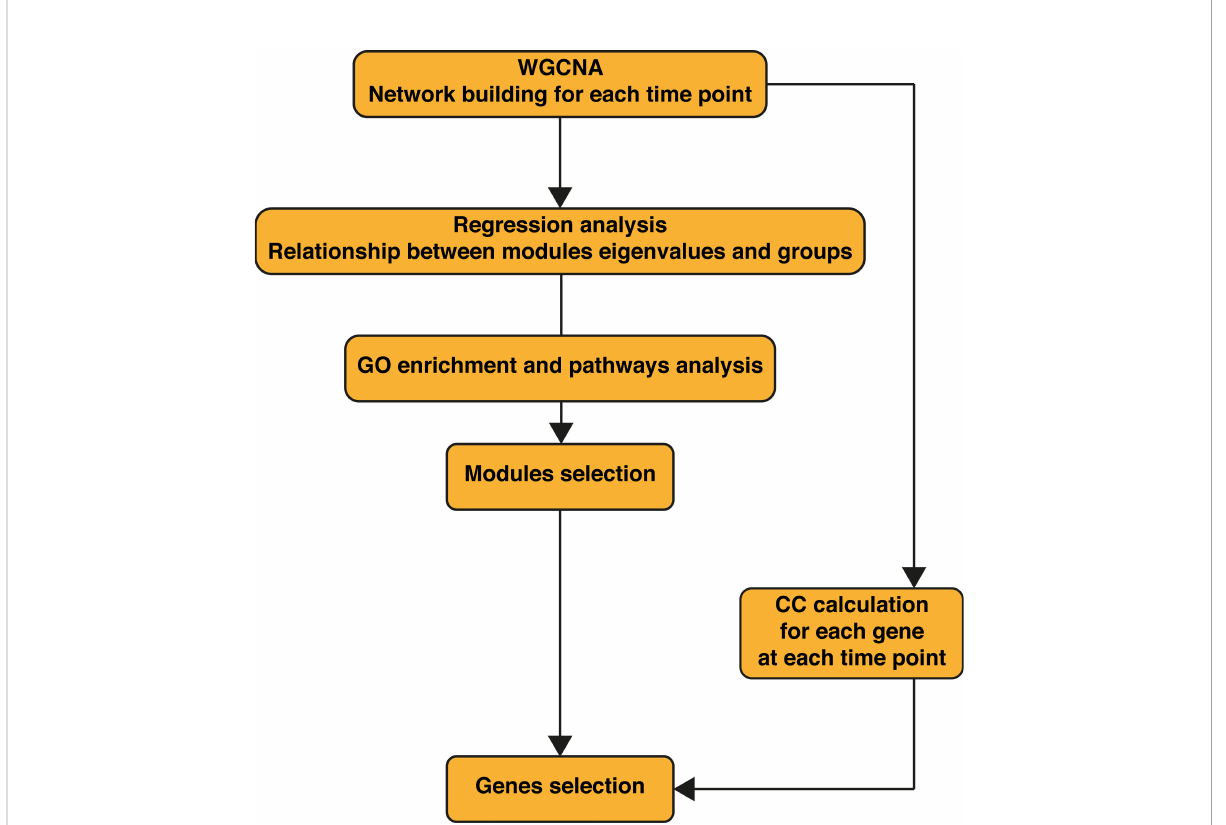
FIGURE 1 Work fl ow of the bioinformatics analysis. WGCNA was performed fi rst on the wild-type (WT) samples alone, then on WT + Ifnar -/- samples merged. Regression analysis was performed on obtained modules to assess their relationship to phenotypes (infection groups). Gene Ontology (GO) enrichment was performed for each module. WT + Ifnar -/- network resulting from weighted gene correlation network analysis (WGCNA) was used to calculate the closeness centrality (CC) of genes at 8 and 24 h postinfection